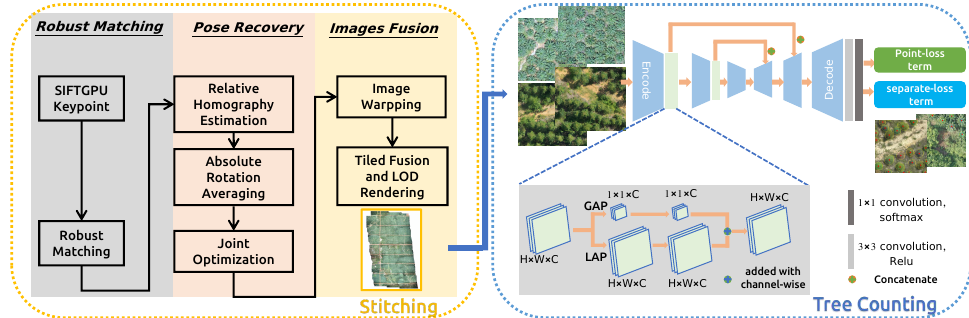
Figure 1. The algorithm presented in this paper is an integrated vision framework, which consists of “real-time stitching” and “fast tree counting” modules. This framework could be easily applied into the embedded system for UAVs; it makes the UAV support online georeferenced large-scale low-overlap aerial images stitching and fast tree counting tasks, which could greatly improve work